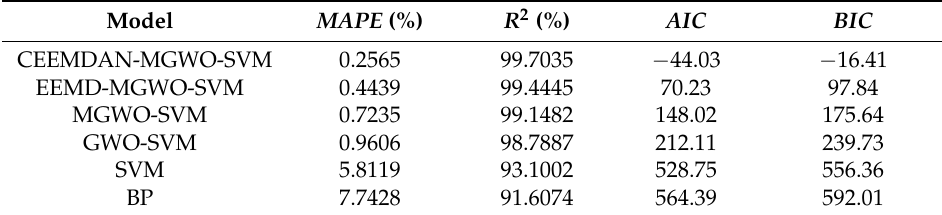
Table 7. Comparison of the forecasting accuracy for different models.